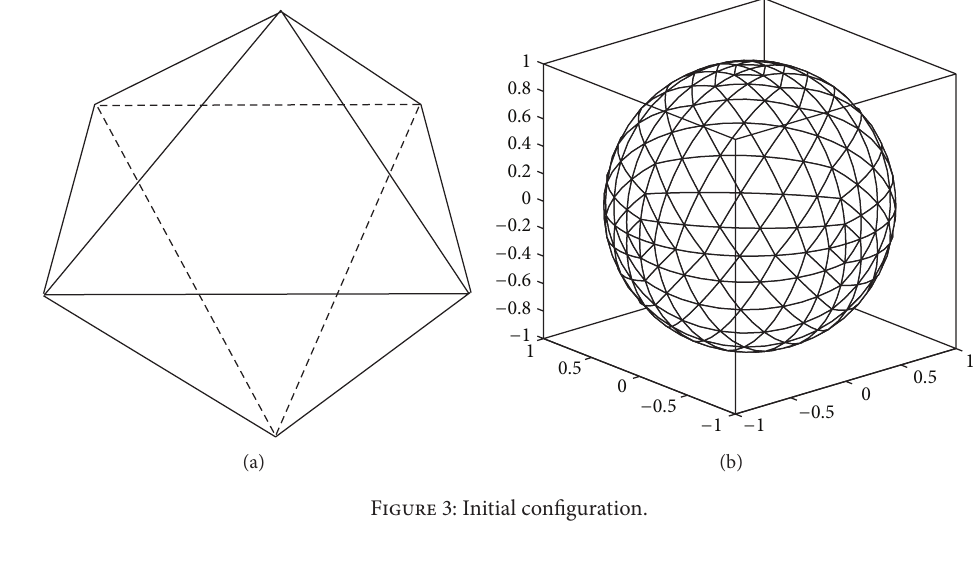
Figure 3: Initial